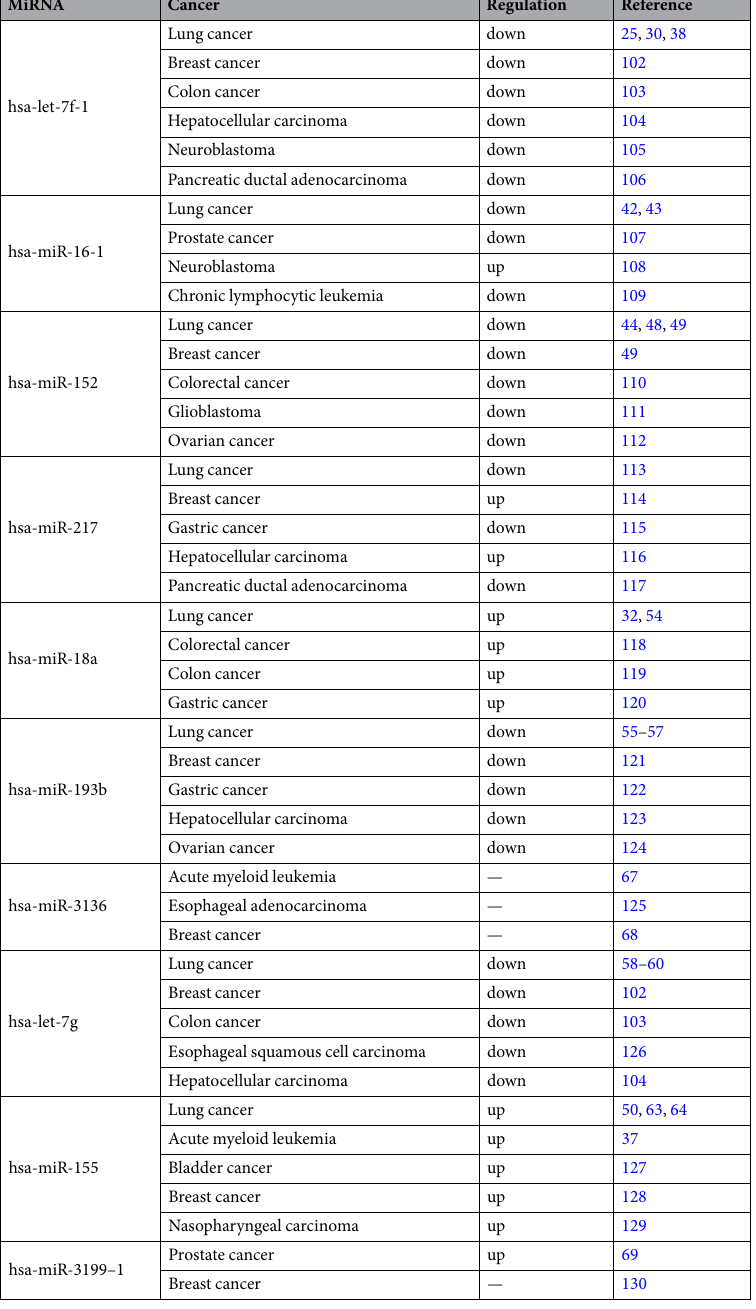
Table 3. The top-10 miRNAs involved in various